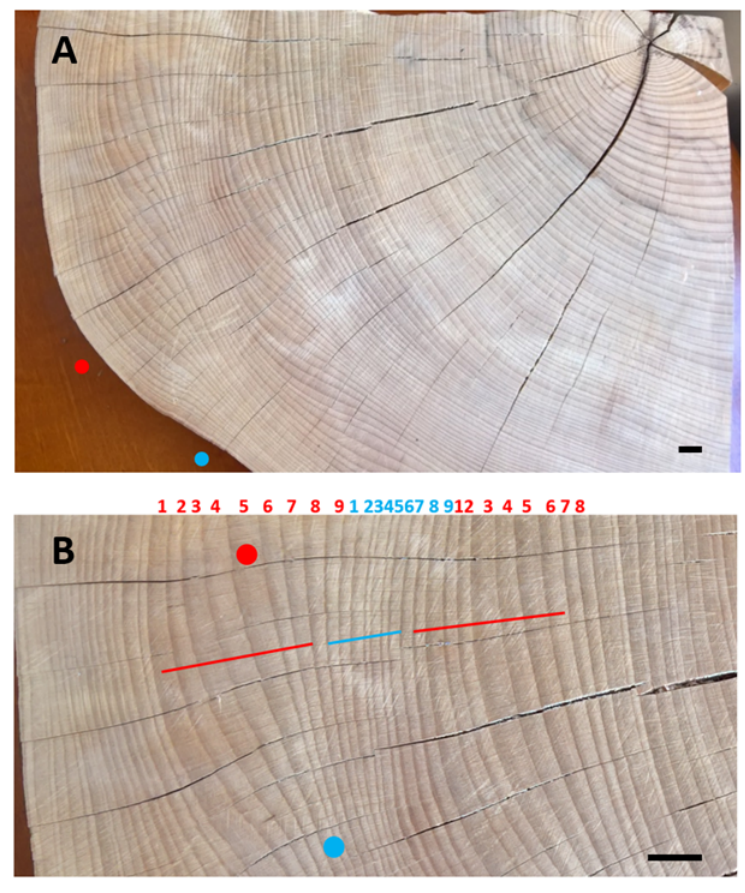
Figure 2 Polished upper surface of a beechwood sample with Z-oriented ripples; ( A ) sinusoidal outline of the sample edge marks the presence of circumferentially neighboring crests (red dot) and throughs (blue dot). e pattern of the annual rings shows the areas of ring widening and narrowing shiing counterclockwise in time; this means that the ripple pattern migrated downward; ( B ) magnified view of the ring pattern show sequences of narrower (blue) and wider (red) rings along radial cracks marking the course of wood rays; red and blue dots show how the same annual ring wide in one location becomes narrow in the neighboring area. Scale bars: 10